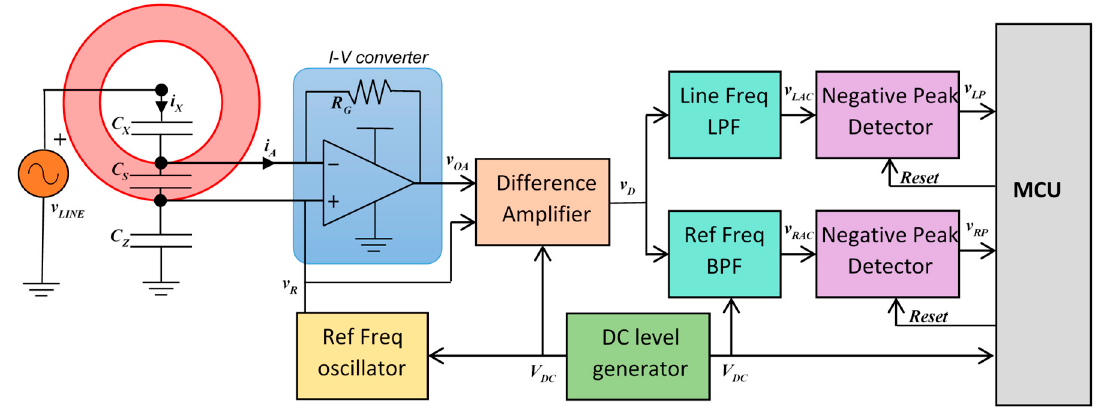
Figure 2. Block diagram of the low-power analog front end.